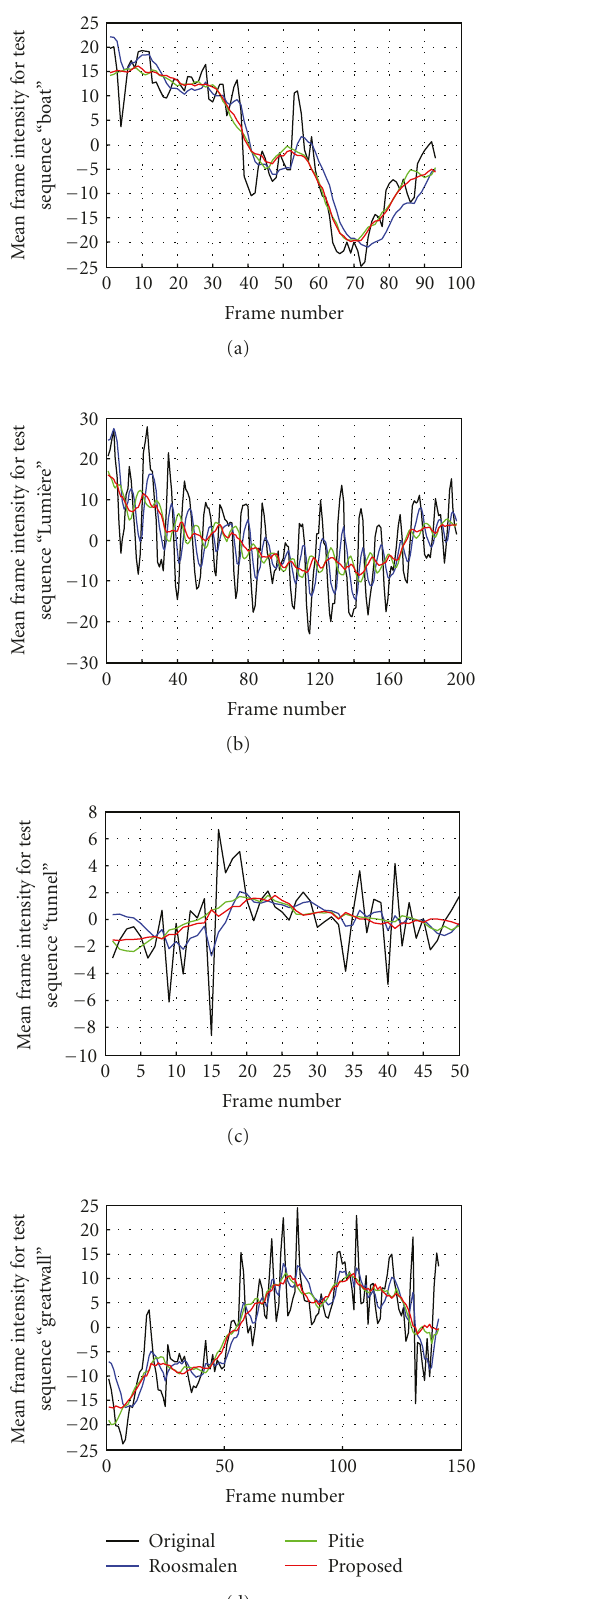
Figure 13: Comparison of mean frame intensity as a function of time.